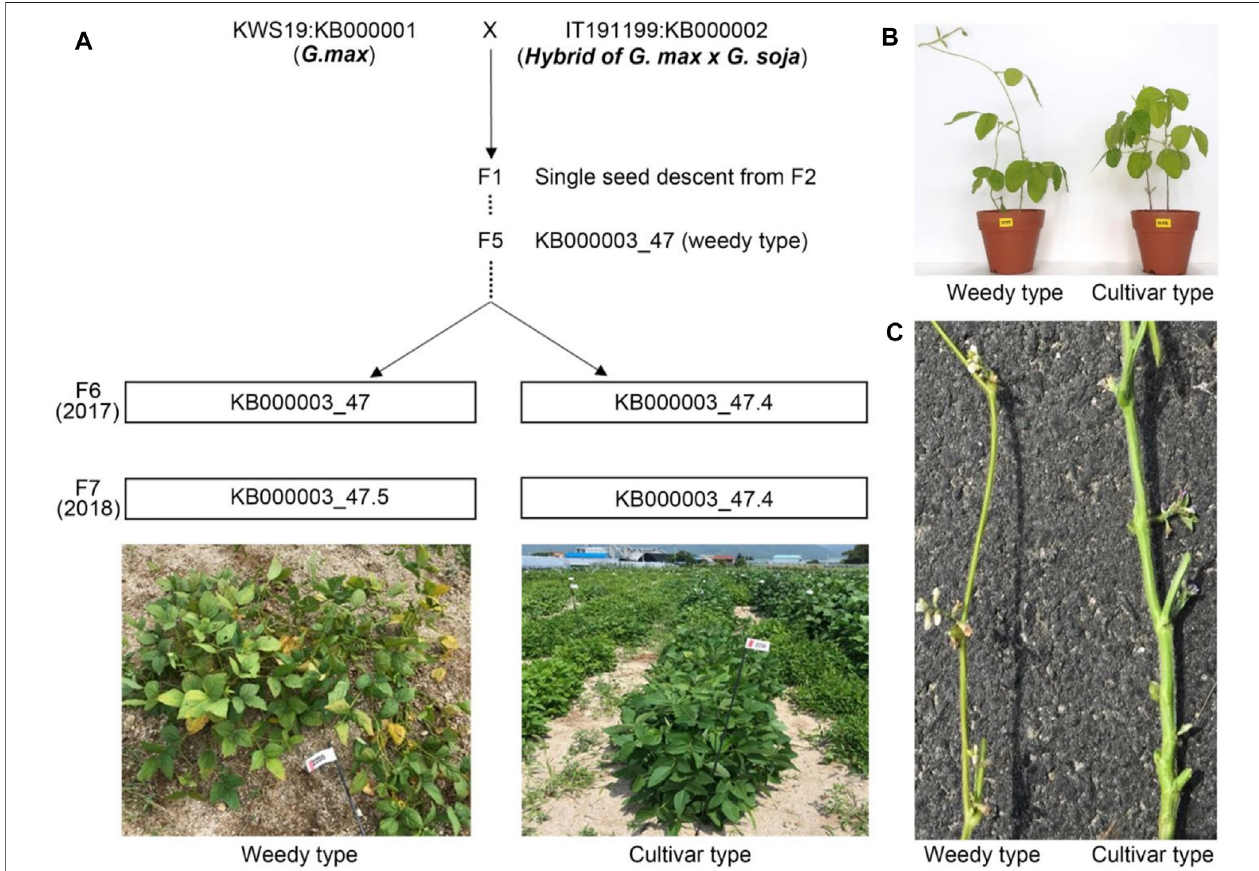
FIGURE 1 | Population phenotypes and crossing scheme used to generate the recombinant inbred lines (RILs). (A) Standard parents G. max (KWS: KB000001) and a hybrid of G. max and G soja (KWS: KB000001) were used for crossing, and their phenotype distribution descended from F2 to F7. Individual lines from F6 displaying parental phenotype, i.e., weedy (KB000003_47.5) and cultivar type (KB000003_47.4), continues in F7. (B) Morphology of weedy and cultivar growth type plants (F7 generation).Eight-week-old plants were grown in a greenhouse. (C) The stems ofweedy type plants and cultivar type plants have different morphology. The F7 generation weedy and cultivar type plants were grown in the fi eld under normal conditions.